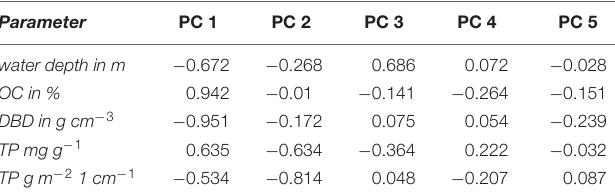
concentration: 0.06–0.10 mg TP g − 1 , TP stocks: 0.75–1.37 g TP cm − 2